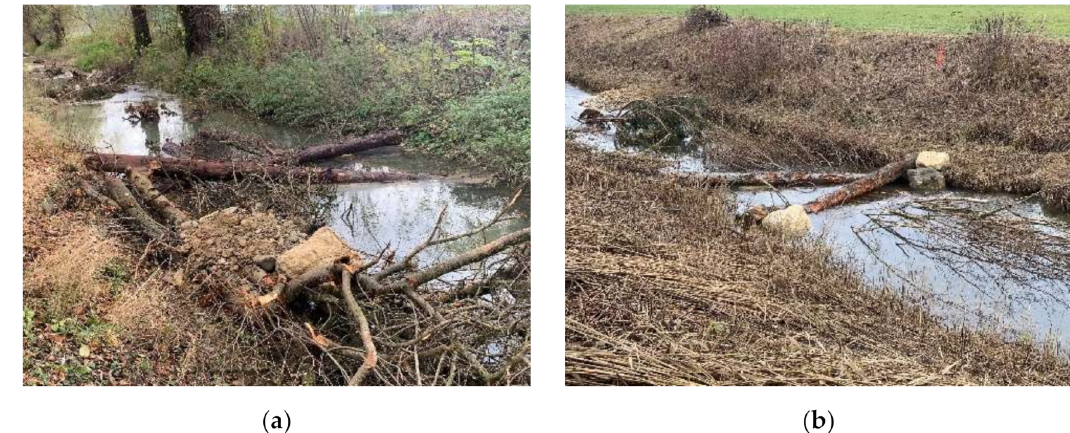
Figure 4. ( a ) Example of a LWS placed parallel to flow direction with little morphologic effect; Scherlibach stream; Photo: M. Mende. ( b ) Example of a LWS placed parallel to flow direction with additional perpendicular LW logs placed in the main current; Scherlibach stream; Photo: M. Mende.